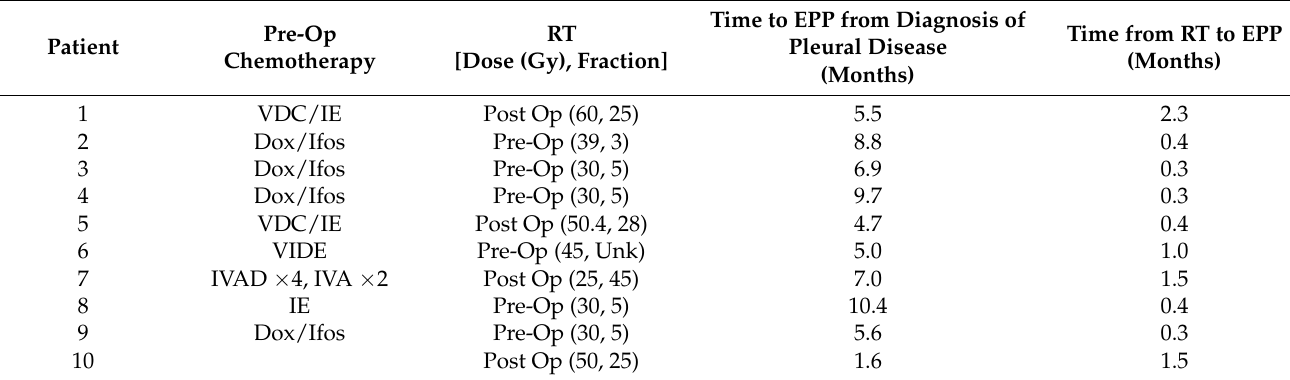
Table 2. Chemotherapy and radiation (RT) of patients.